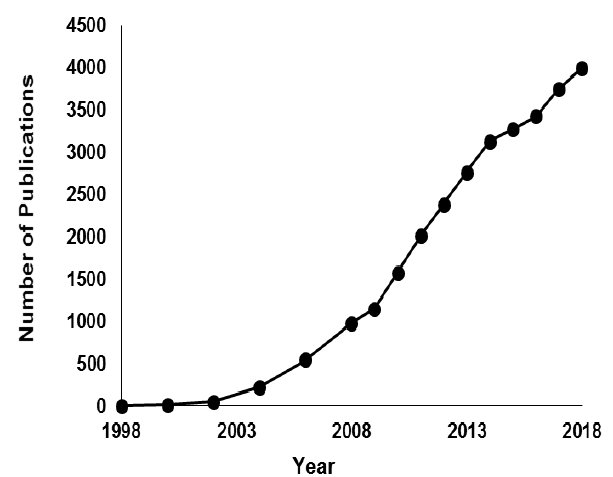
Figure 1. The annual number of English-written journal articles published in the period from 1998–2018, as derived from SciFinder Scholar using the keyword “electrospinning”. As of 6 May 2019, there are 1855 publications.